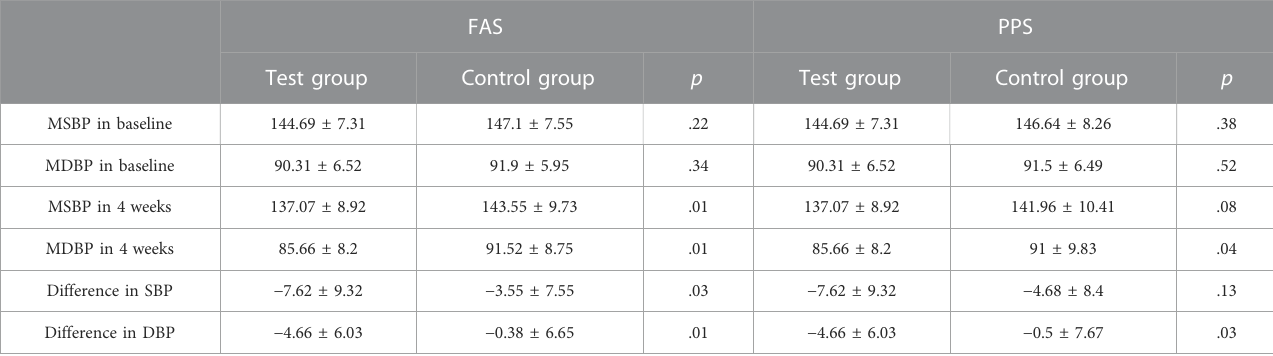
TABLE 4 Changes in of fi ce BP (FAS,